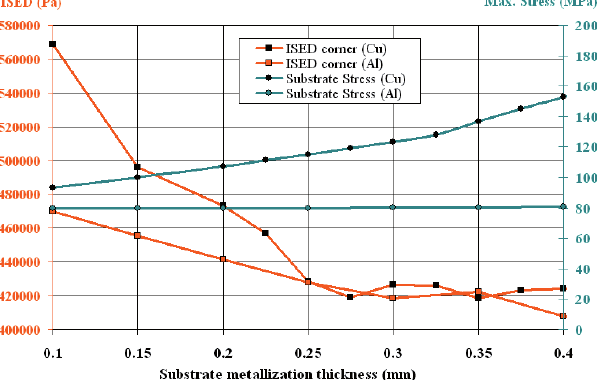
Fig. 25. Evolution of base plate solder corner ISED and sub- strate maximal principal stress with metallization nature and thickness.